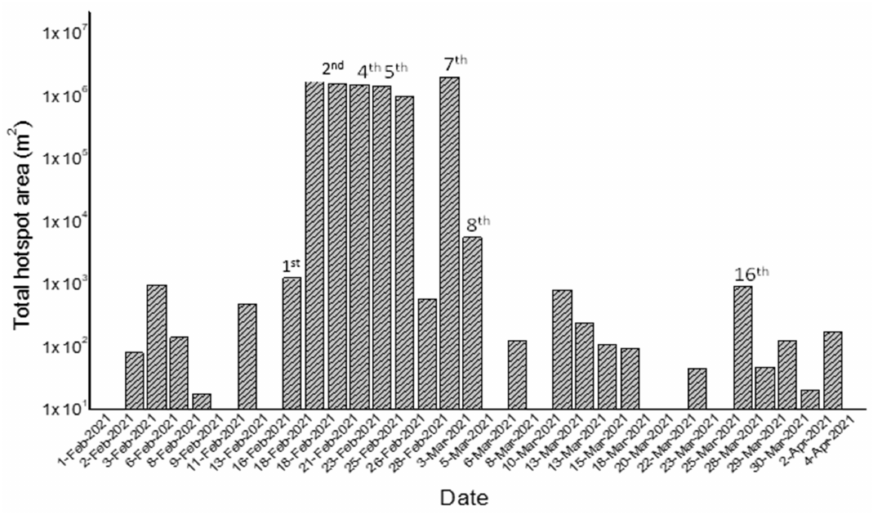
Figure 4. Temporal trend of the total hotspot area (m 2 ) retrieved using NHI tool, by integrating L8-OLI and S2-MSI observations over the period 1 February–4 April 2021, with the indication of the relative paroxysm.